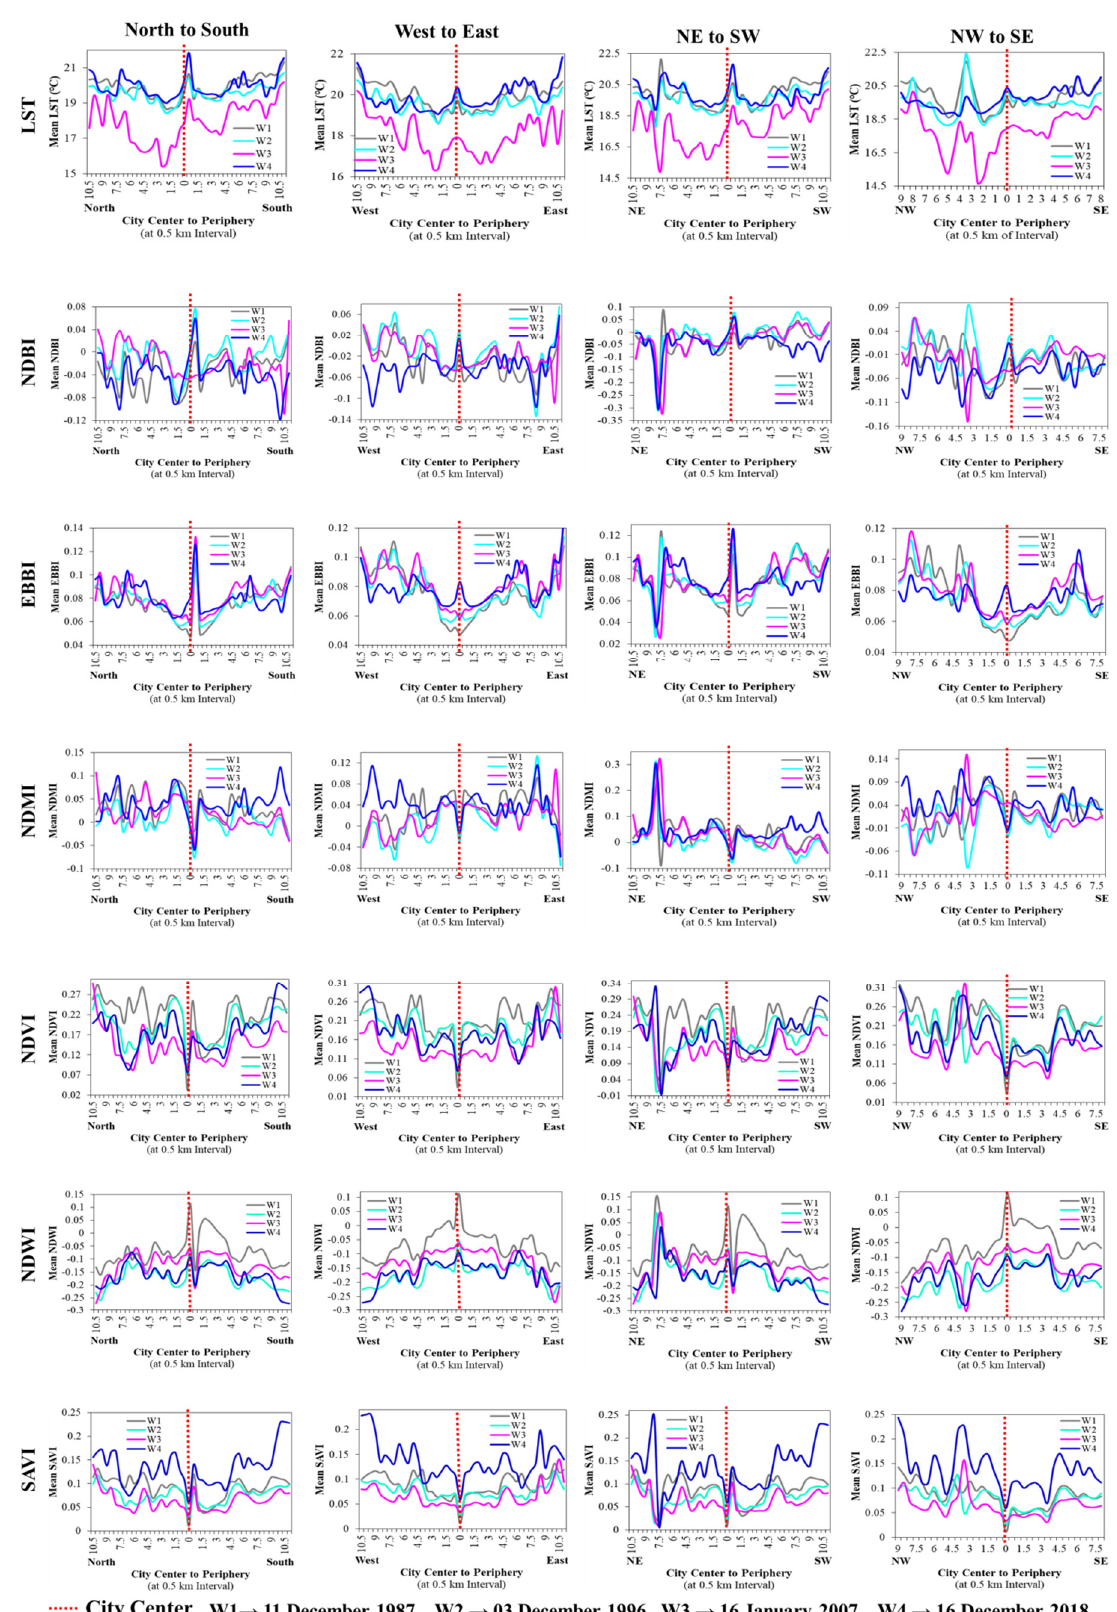
Figure 16. Effects of the land indices on the distribution of LST dynamics in the winter season in Prayagraj city (1987–2018).